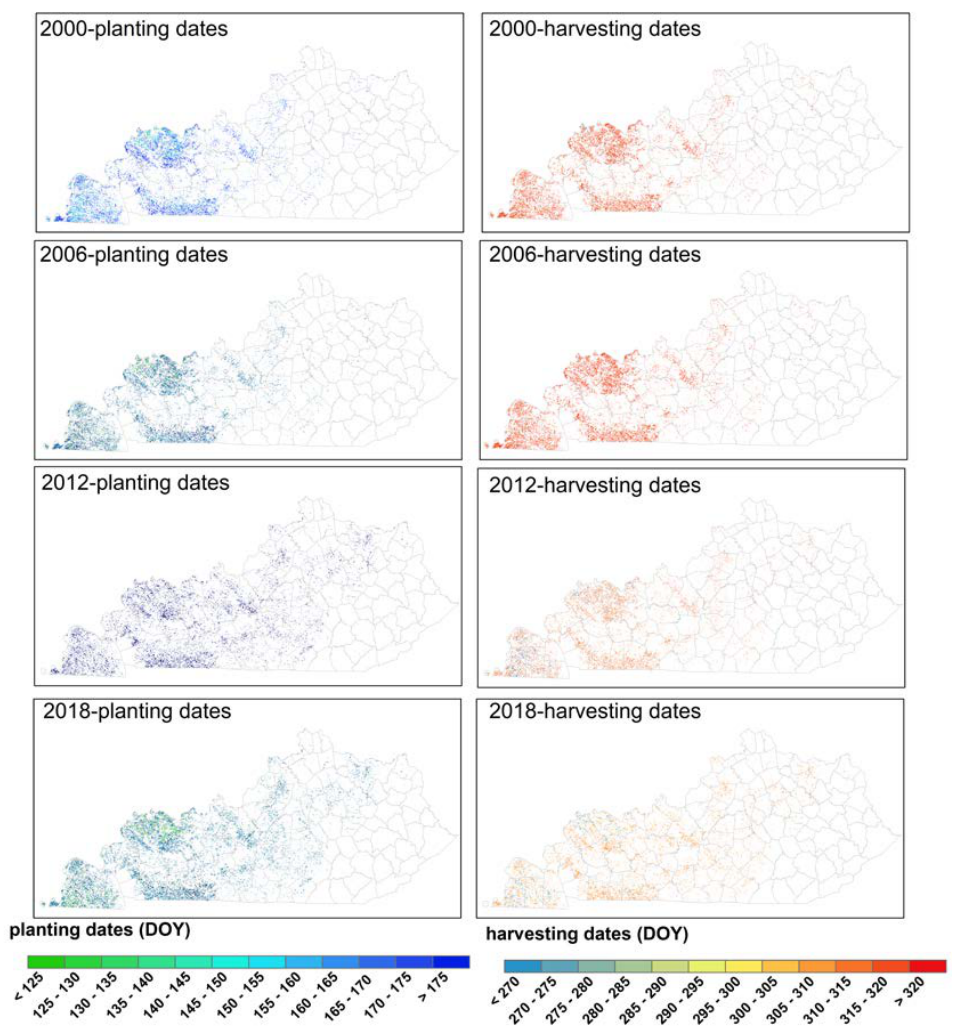
Figure 6. Spatial variations of soybean phenological stages in Kentucky.